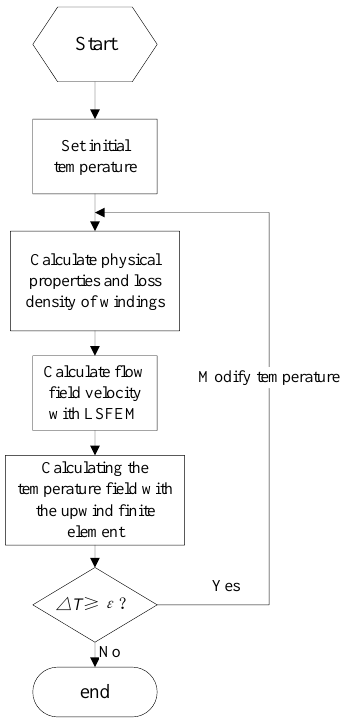
Figure 1. Process of fluid-thermal coupling calculation.